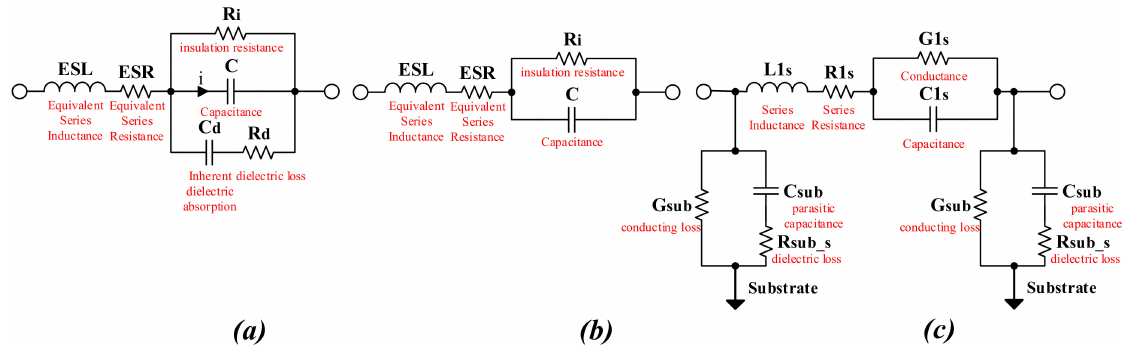
Figure 4. Equivalent circuit model of a capacitor: ( a ) AE-C; ( b ) MPF-C; and ( c )